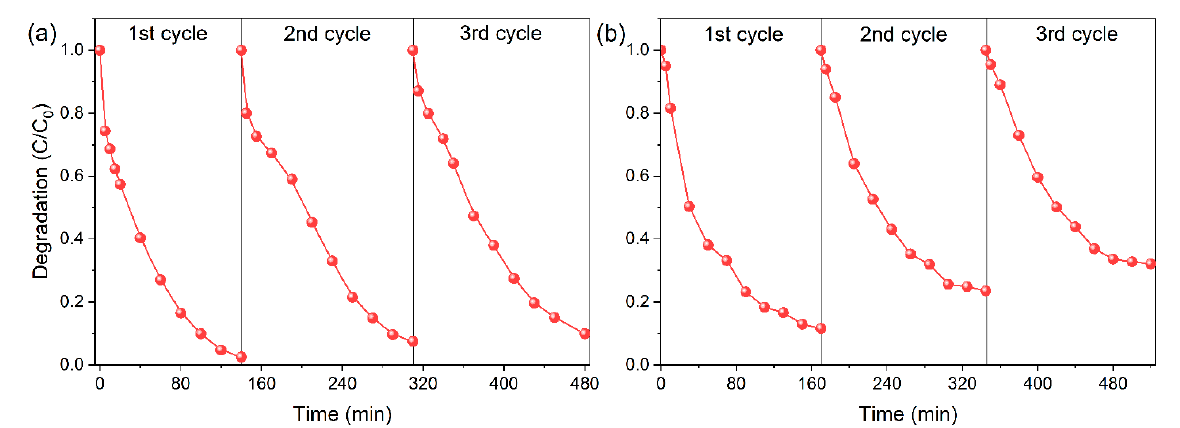
Figure A4. Cyclic photocatalytic degradation of ( a ) RhB and ( b ) BPA in the presence of 20- Co 3 O 4 /BOC sample.